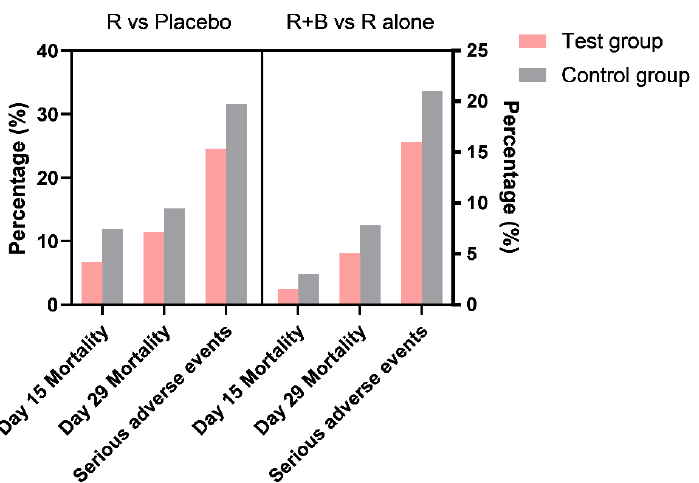
Figure 4. Remdesivir versus remdesivir plus baricitinib clinical trials. Comparison of mortality rate and serious adverse events of two clinical trials regarding remdesivir (R) compared with a placebo, and remdesivir in combination with barcitinib (R+B) compared with remdesivir alone (R alone). Data source: Remdesivir for the Treatment of COVID-19—Final Report [139], Baricitinib plus Remdesivir for Hospitalized Adults with COVID-19